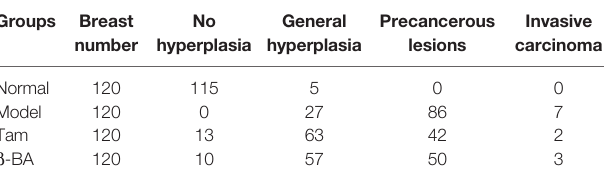
TABLE 2 | The pathological changes of mammary gland tissue in rats in each group. Groups Breast